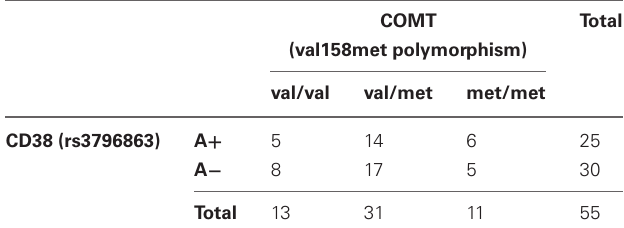
Table 1 | Distribution of CD38 and COMT genotypes in the sample.